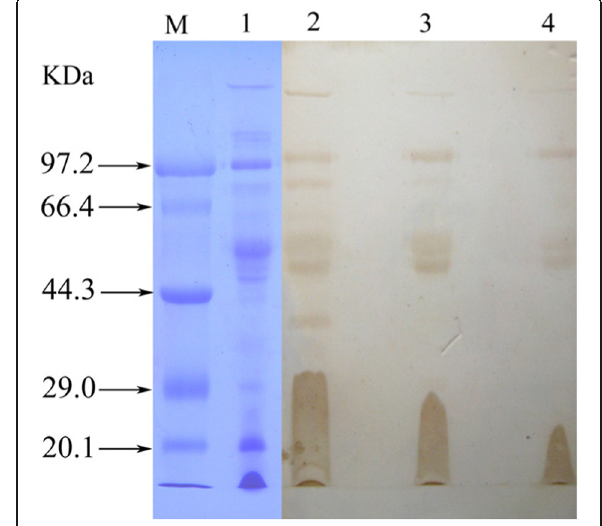
Fig. 3 Identification of anti- T. albolabris venom IgY. The reduced IgY (50 μ g) was separated on 10 % SDS-PAGE and stained with Coomassie brilliant blue (lane M: molecular weight marker; lane 1: reduced IgY). Result of Western blot test using peroxidase conjugated rabbit anti-chicken IgY to detect the heavy chains (lane 2: A) and the light chains (lane 2: B)